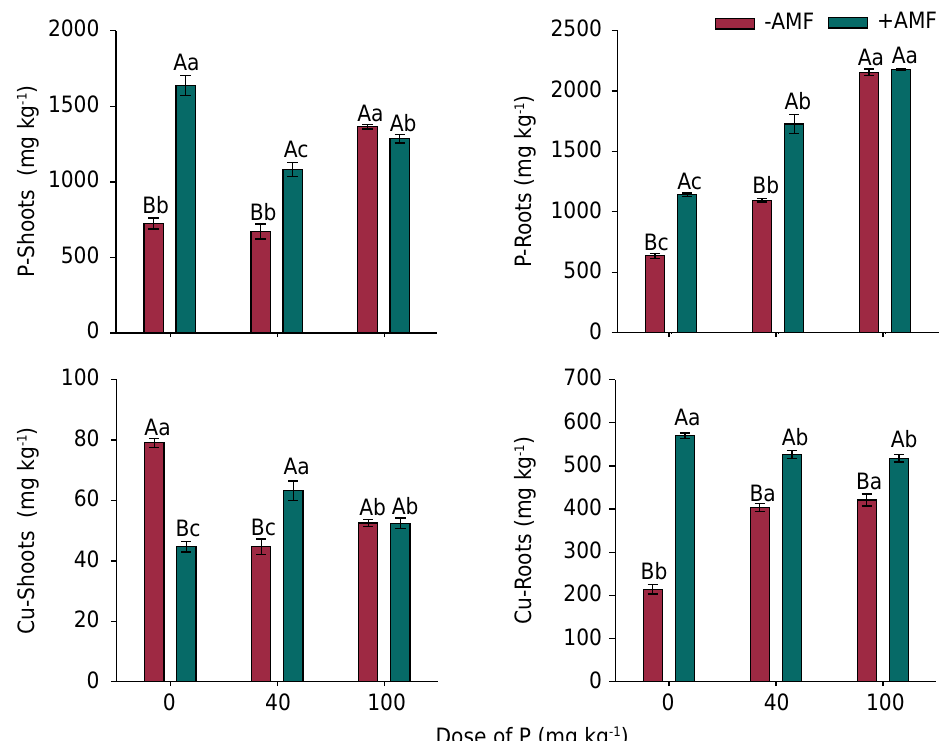
Figure 4. Phosphorus and Cu content in shoots and roots of Crotalaria juncea plants growing in a soil with high copper (60 mg kg -1 ) levels under different levels of phosphorus with and without AMF inoculation. Vertical bars above the columns indicate the standard deviation. Means followed by the same lowercase letter compare doses in the same condition inoculation and uppercase letters compare inoculation within the same dose of P (Tukey 5 %).